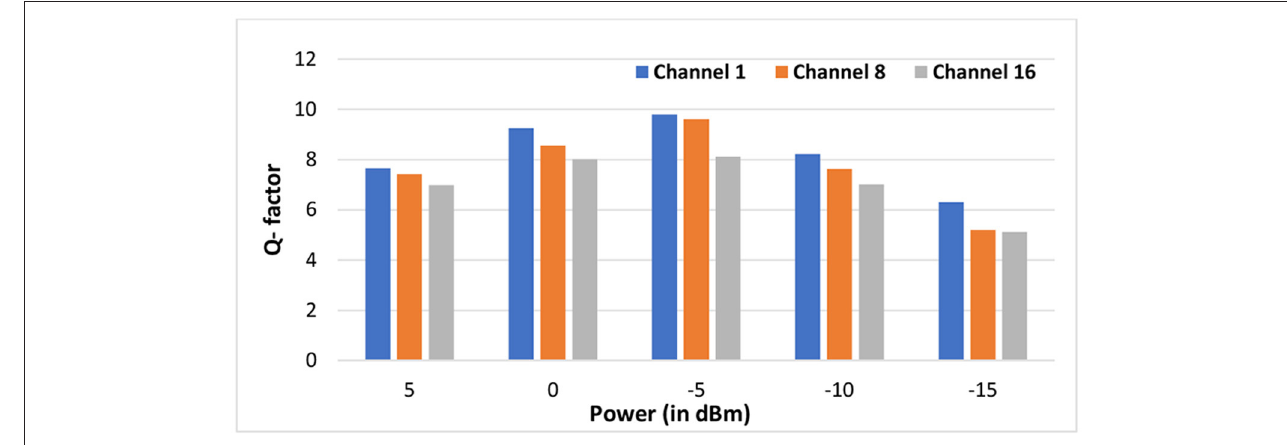
FIGURE 6 | Variation of Q factor with power at channel spacing of 50 GHz.